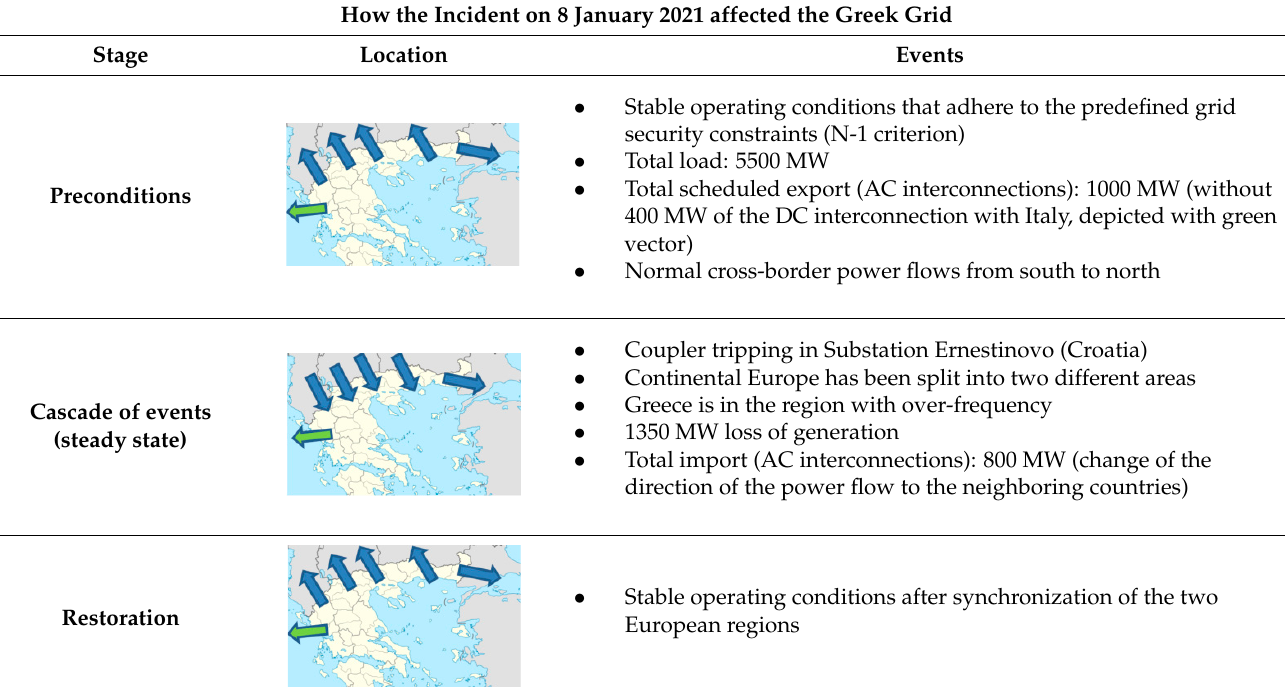
Table 6. Sequence of events during the European split in Greece on 8 January 2021 and a hypothetical scenario.